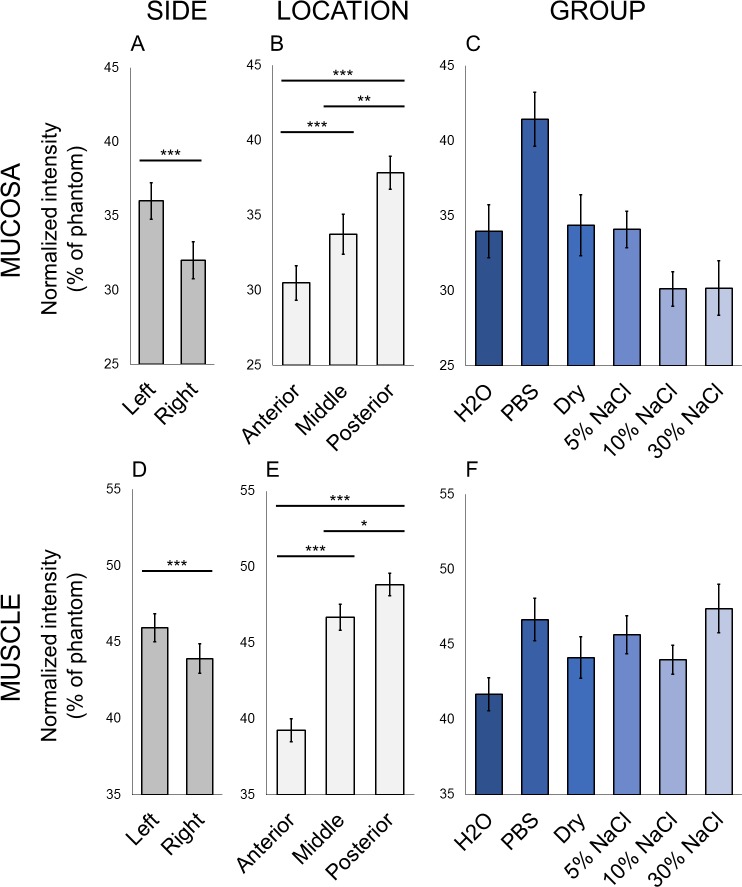
Baseline tissue intensity varied by side and location within vocal folds.Normalized intensity (% of phantom) at baseline in mucosa (A-C) and muscle (D-F). (A) and (D): Left and right vocal fold. (B) and (E): Location in vocal fold. (C) and (F): Experimental group. Data plotted as mean ± SEM. n = 5 larynges per group. *p<0.05, **p<0.01, ***p<0.001: significance of pairwise comparisons of group means using Tukey’s HSD test after significant main effects were found in mixed model ANOVAs.